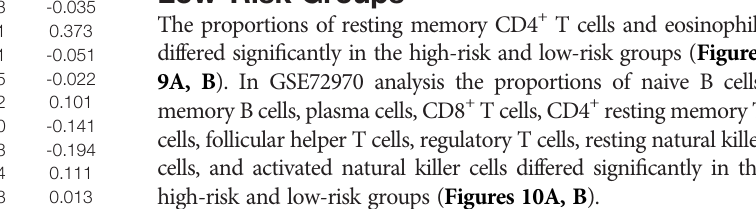
Meier curve analysis ( Figure 7A ). In analysis of time-dependent ROC curves to assess the effects of the classi fi er the AUCs were 0.68 at 1 year, 0.68 at 3 years, and 0.74 at 5 years ( Figures 7B – D ). In GSE72970 analysis patients with high risk scores exhibited a lower survival rate than those with low risk scores ( Figure 7E ). The AUC was 0.729 at 5 years ( Figure 7F ). Univariate and multivariate Cox regression analysis revealed that age, TNM stage, and risk score in the prognosis model were signi fi cantly associated with survival ( Table 3 ).